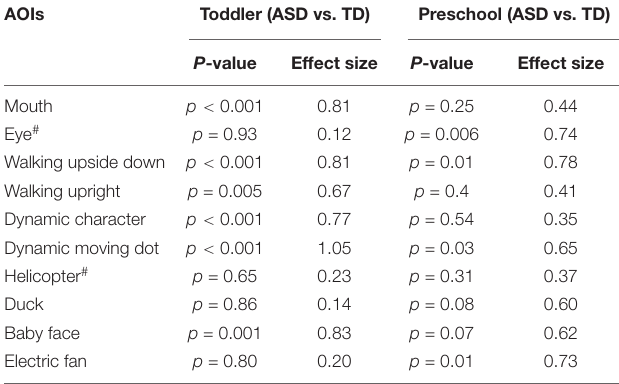
TABLE 3 | Fixation time percentage differences